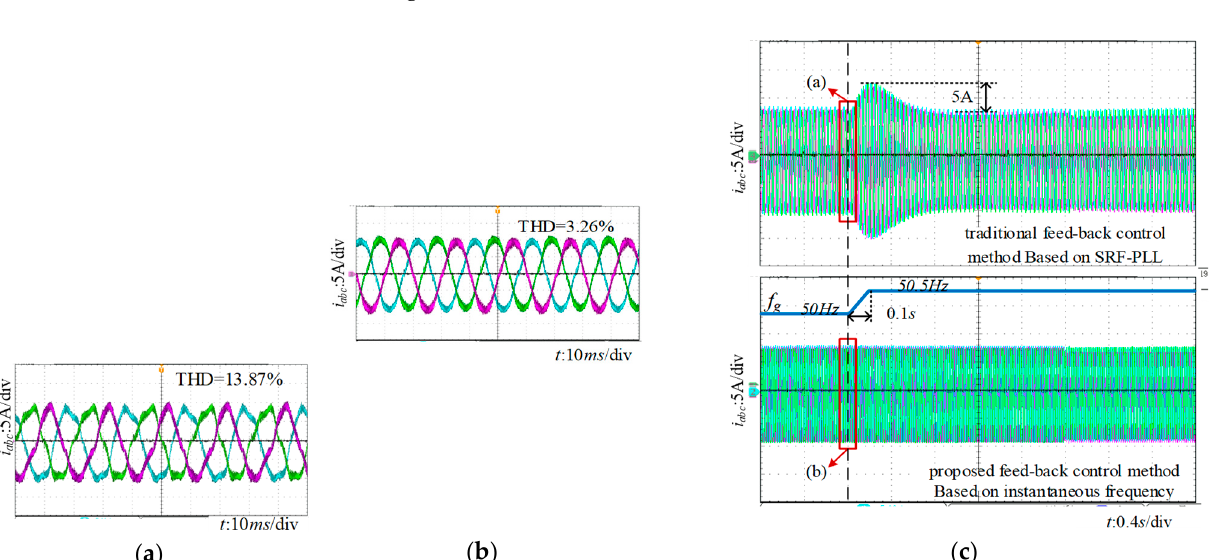
Figure 12. Experimental prototype developed in the laboratory. From Figure 13c, the grid voltage fundamental frequency changed from 50 to 50.5 Hz with harmonics, and the corresponding current responses of the proposed harmonic cur- rent suppression control method was observed to be faster and more stable compared with the traditional feed-back control method. The maximum oscillation value of the cur- rent reached 5 A of the traditional feed-back control method based on SRF-PLL. The meas- ured total harmonic distortion (THD) of the injected grid current is shown in Figure 13a,b, and the measured THD values of the injected grid currents were 13.87% and 3.26%, re- spectively. It can be observed that the grid voltage distortion affected the injected grid current of the micro-gird inverter and the proposed harmonic current suppression control scheme suppressed the injected grid current harmonics and inter-harmonics. Compared with the traditional feed-forward control method, the proposed strategy performed better in terms of suppression of the injected grid current harmonics.